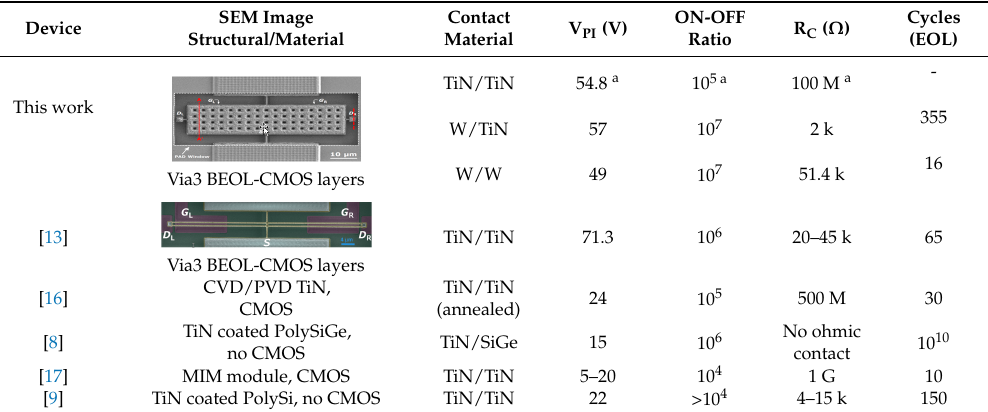
a Only measurements in air conditions due to the aluminum over-etching